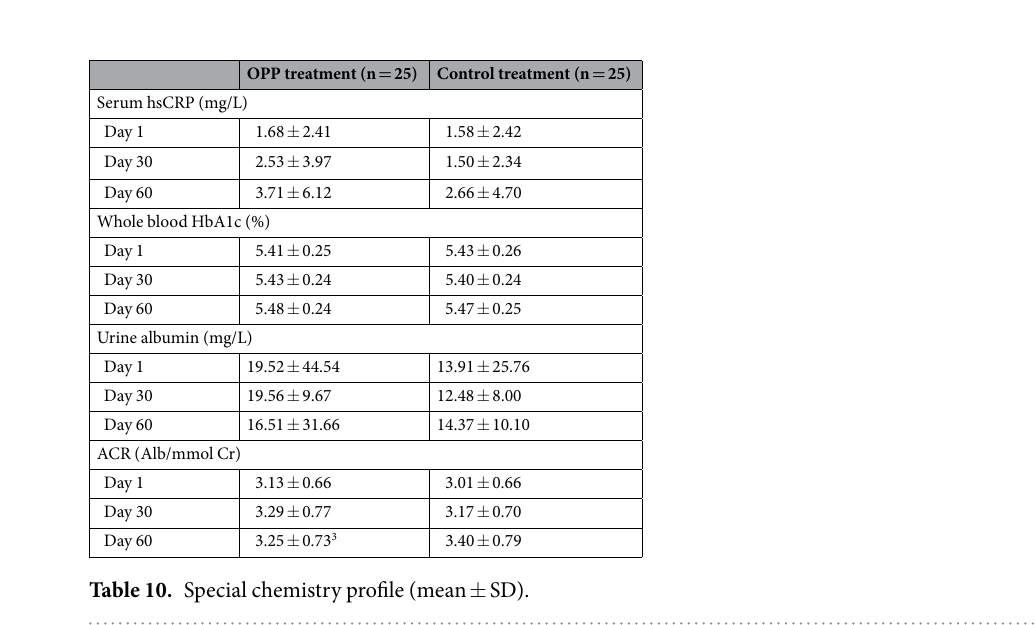
Table 9. Endocrinology profiles (mean ± SD).